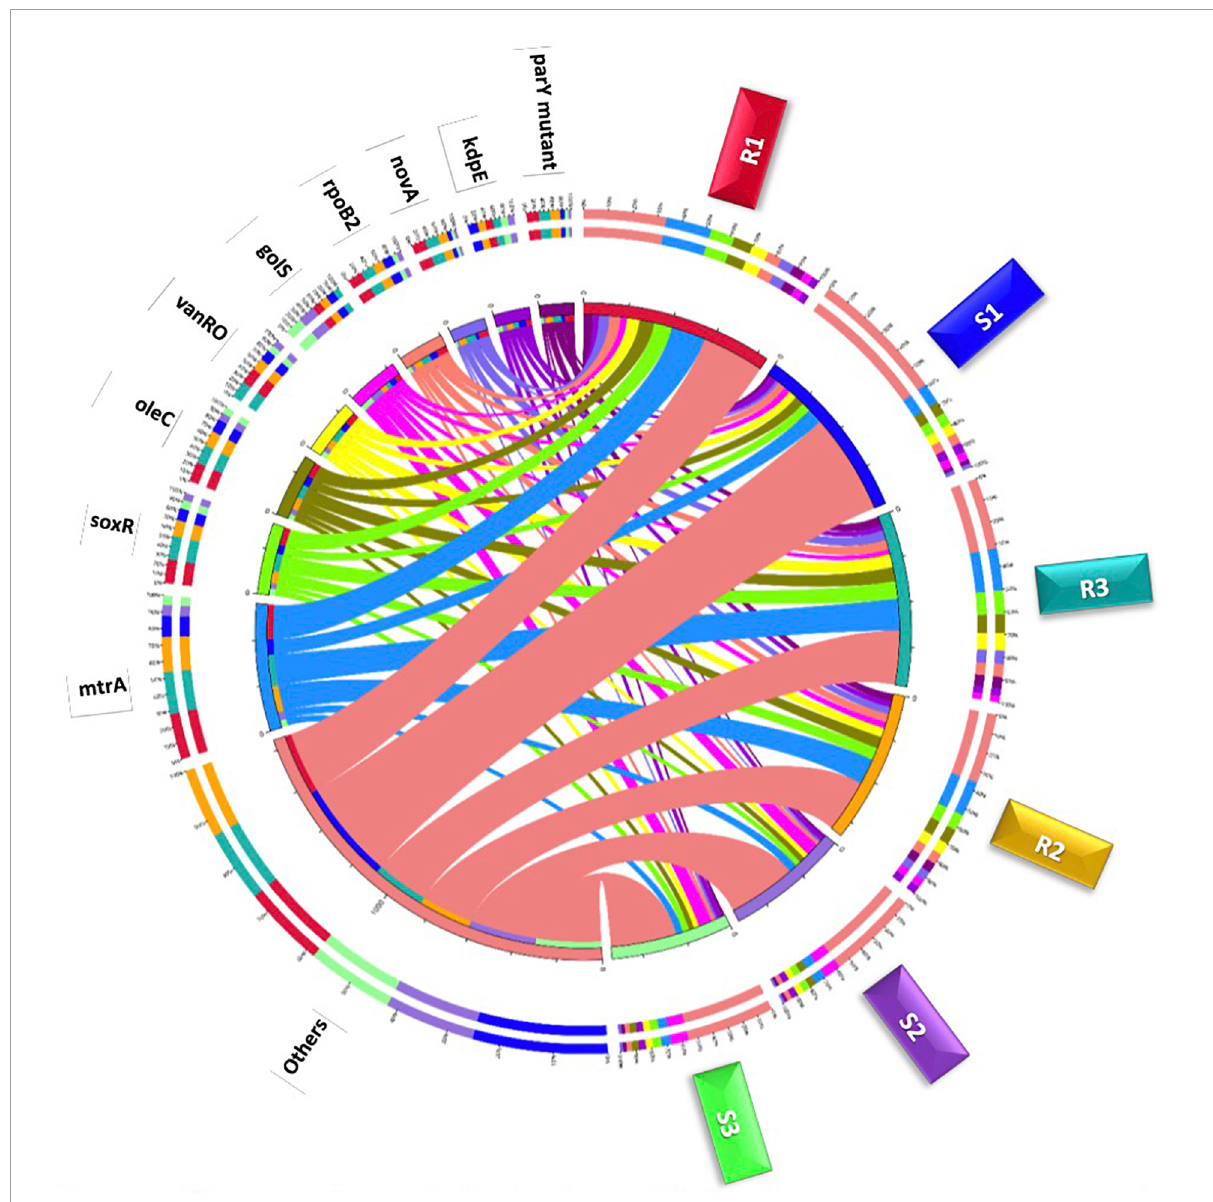
FIGURE4 Circle chart of the top highly abundant antibiotic resistance genes ( > 20 ORFs/ARG) in different samples of rhizobiomes (Rl–R3) and bulk soil (S1–S3) microbiomes surrounding Moringa oleifera. The chart is divided into two sides, where the right one refers to samples (S and R) information and the left refers to antibiotic resistance genes (ARGs) information. The wideness of different scales of inner and outer circles refers to relative abundances of ARGs and samples. Colors in inner circle refer to sum of relative abundance of all ARGs per sample (right side) and sum of relative abundance of all samples per ARG (left side) . While, colors in outer circle refer to detailed relative abundance of different ARGs per sample (right side) and detailed relative abundance of different samples per ARG (left side)